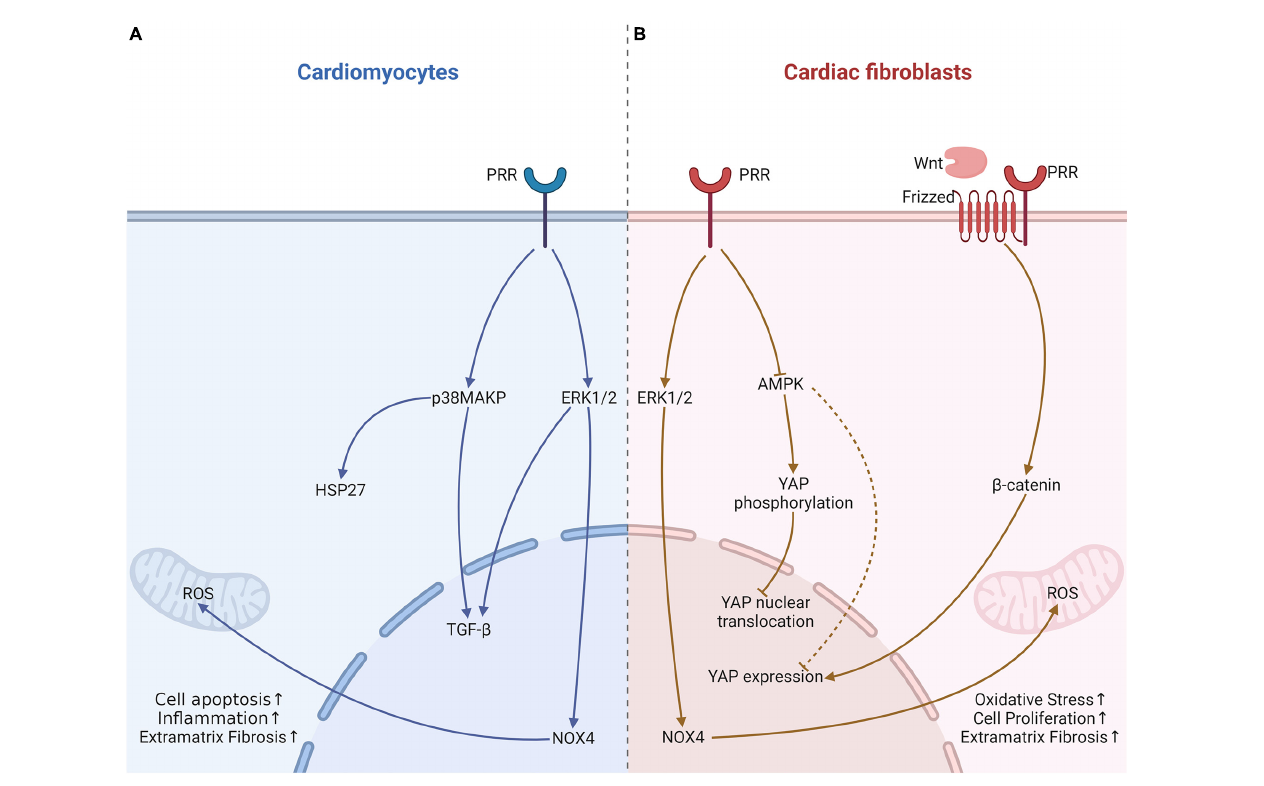
FIGURE2 The effects of PRR on cardiomyocytes and fibroblast in heart tissue with metabolic cardiomyopathy. (A) In cardiomyocytes, PRR promotes cardiomyocytes apoptosis via p38MAPK-HSP27, facilitates TGF- β expression via ERK1/2 leads to fibrosis, and causes oxidative stress through increasing NOX4 expression. (B) PRR promotes YAP expression, further causes fibroblast proliferation and myocardial fibrosis. This effect of PRR maybe associate with AMPK and Wnt. PRR may also regulates YAP phosphorylation and nuclear